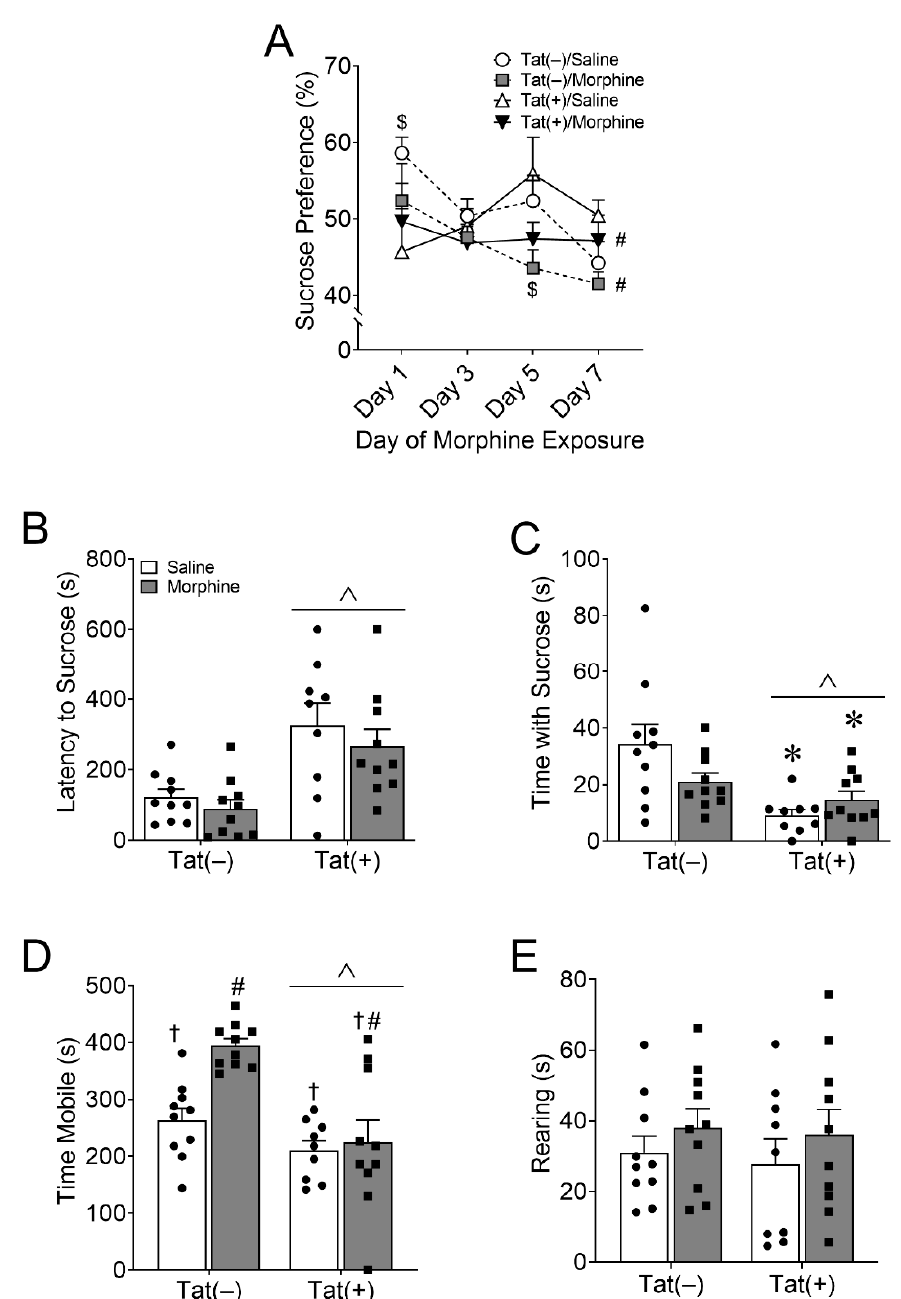
Figure 2. Morphine decreased sucrose preference, whereas HIV-1 Tat decreased novelty-induced sucrose hypophagia. Escalating doses of morphine (10–40 mg/kg, increasing by 10 mg/kg/2 day, s.c., b.i.d.) for 1 week decreased home cage sucrose preference in the two-bottle choice test. In the two- bottle choice test, home cage sucrose preference was measured every other day (i.e., 48 h) in both